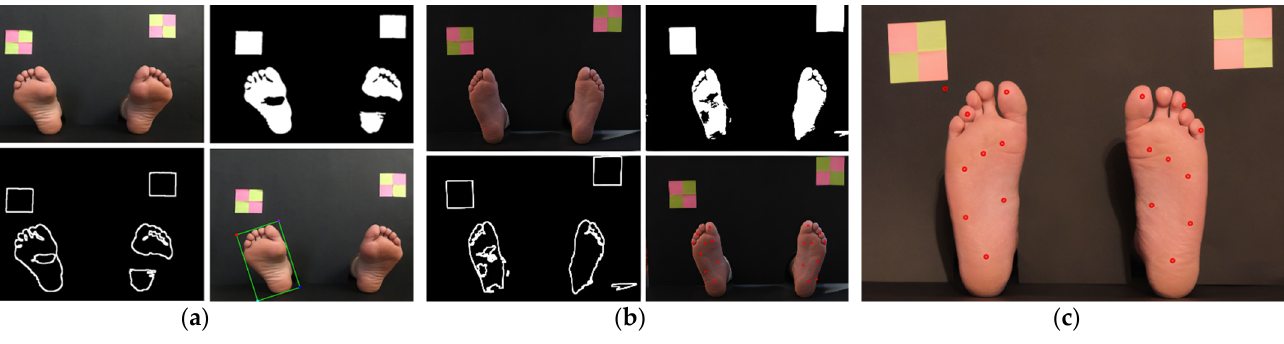
Figure 10. Examples of factors that affect performance: ( a ) feet inclined toward the camera; ( b ) different illumination conditions for the left and right feet; ( c ) dimensional reference marker interference in long feet.